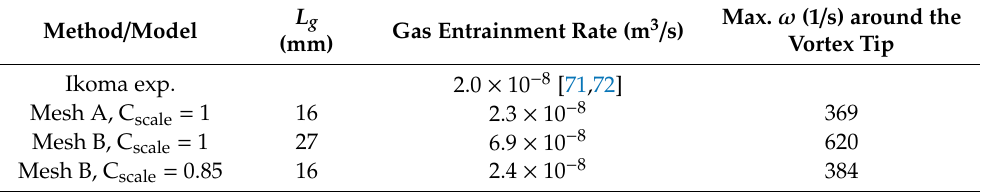
Figure 12. Average interfacial deformation, represented by isosurface, of α cg = 0.5 for cases ( a ) Mesh A and C scale = 1, ( b ) Mesh B and C scale = 1 and ( c ) Mesh B and C scale = 0.85. Table 3. Gas core length, gas entrainment rate, and maximum vorticity.